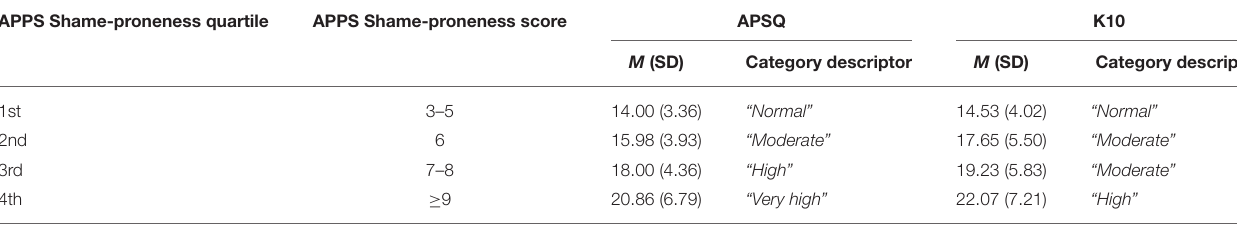
TABLE 6 | APPS Quartiles and corresponding APSQ and K10 indices. APPS Shame-proneness